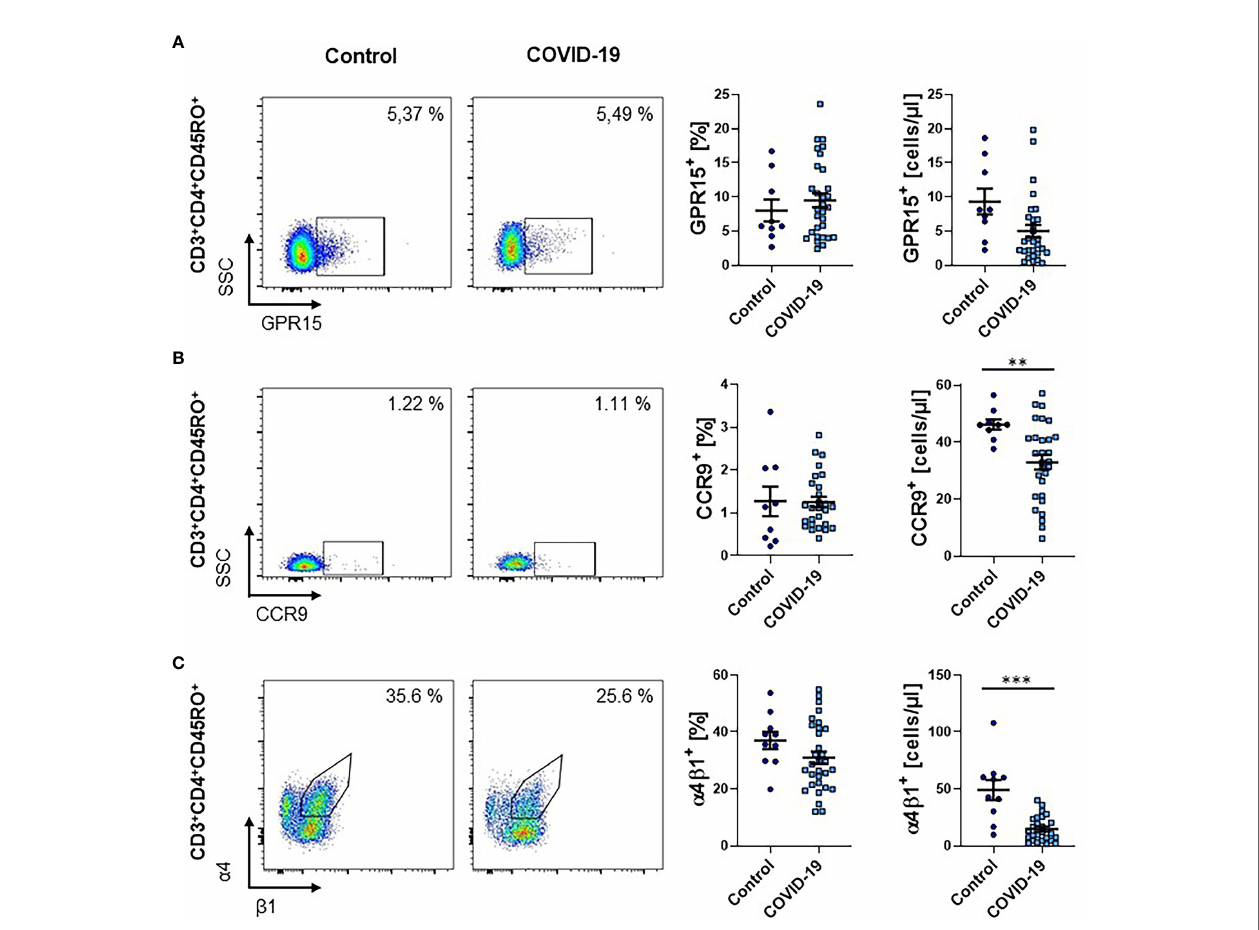
FIGURE 3 | Frequency of other gut homing markers on CD4 + memory T cells during COVID-19. (A – C) Flow cytometry of whole blood samples from COVID-19 patients and healthy controls. Representative (left) and quantitative (right) fl ow cytometry of the frequency and absolute cell numbers of GPR15 + (A) , CCR9 + (B) and a 4 + b 1 + (C) CD3 + CD4 + CD45RO + memory T cells. VDZ, vedolizumab. Each symbol represents an individual subject, n = 10 – 31 per group. **p < 0.01, ***p <